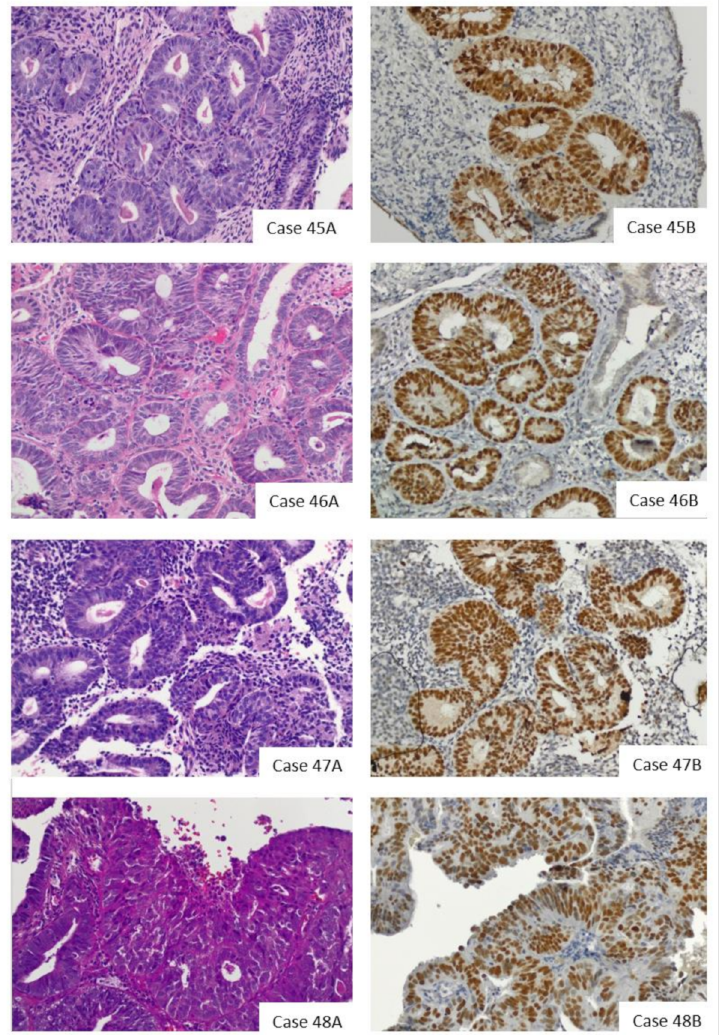
Figure 2. H&E ( A ) and p53 ( B ) staining of the four p53-abnormal (cases 45–48). 45A–48A: H&E images. 45B–48B: IHC demonstrating strong and diffuse p53 staining. Cases 45–47 are endometrial intraepithelial neoplasia (EIN). Case 48 was diagnosed as a grade 1 endometrioid endometrial adenocarcinoma. Photomicrographs (H&E and IHC) were obtained at 20 ×